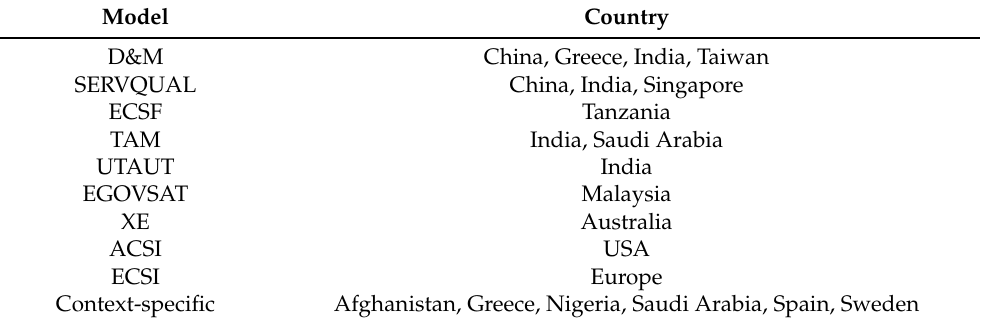
Table 9. Models and context of